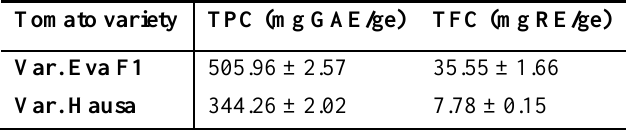
Table 2 : Total phenol and total flavonoids content of extract of tomato leaf; var. Eva F1 and var. Hausa .